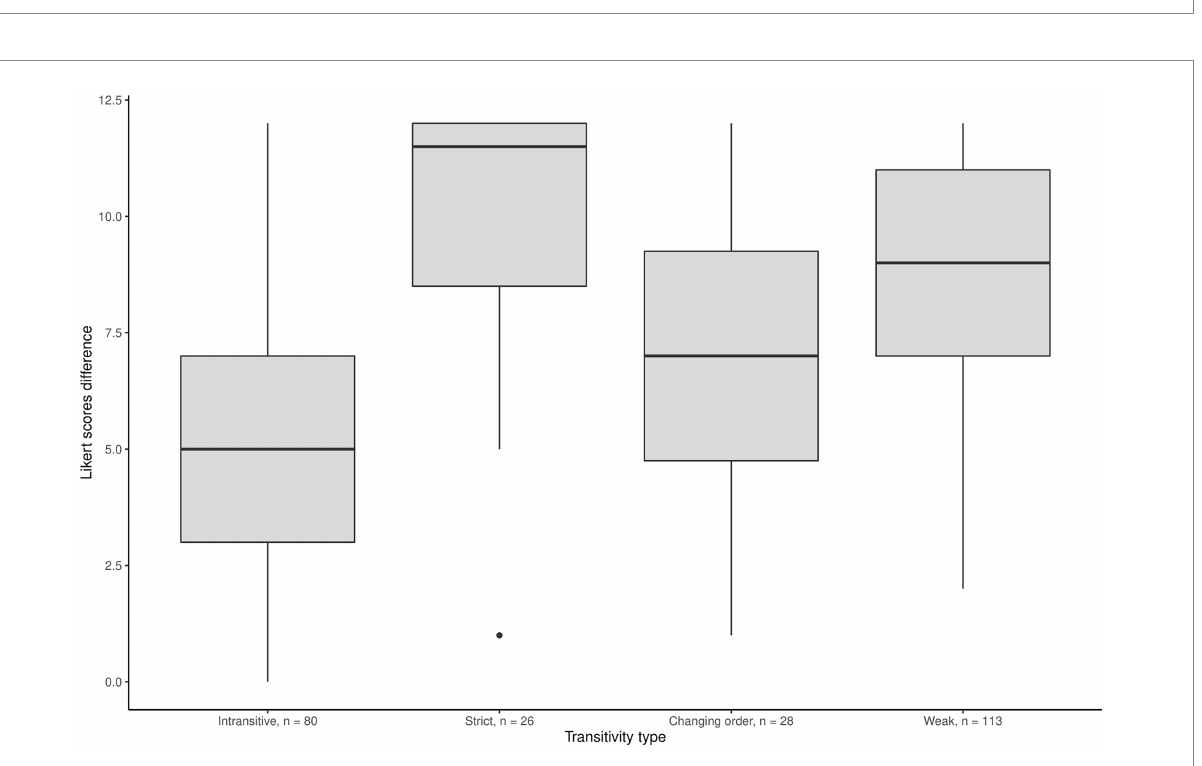
FIGURE 2 Mean difference in Likert scores between internal motivation and amotivation